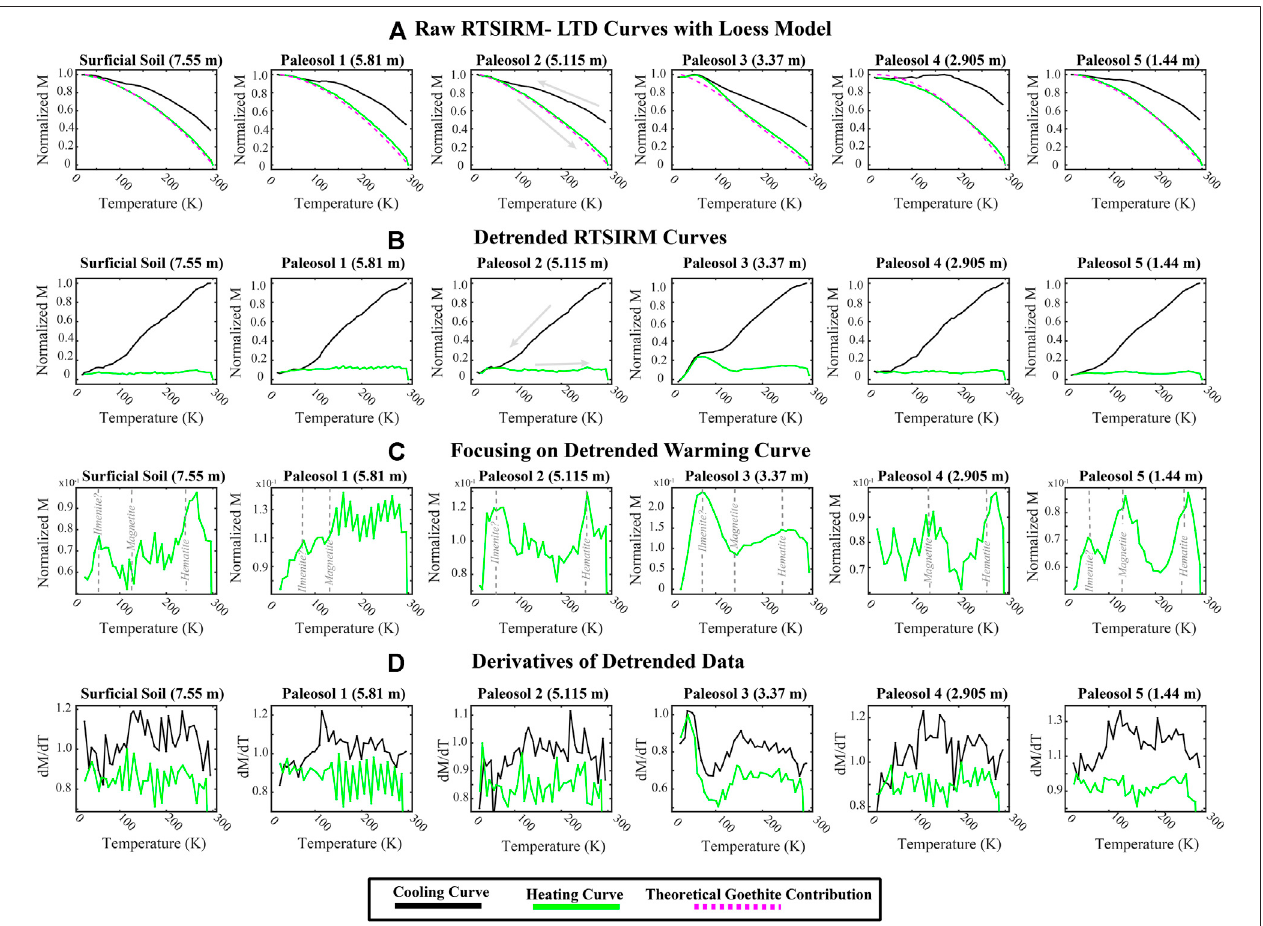
FIGURE 7 | RTSIRM-LTD data. 7a: Cooling (black) and warming (green) RTSIRM curves for all fi ve paleosols and the Sur fi cial Soil. Note the humps present on the coolingcurve,thisisindicativeofmaghemitization(ÖzdemirandDunlop,2010).Thedashedpurplelineisaloesssmoothofthewarmingcurve,representingthepotential contribution of goethite which often has a similar parabolic shape in RT-SIRM curves of synthetic samples (Lascu and Feinberg, 2011). 7b: Subtracting the loess-model from the raw RT-SIRM data, this theoretically removes the goethite contribution. 7c: Focusing on the detrended warming curve, note how the Morin (T M ) and Verwey (T V ) transitions are now visible (Verwey, 1939; Morin, 1950). 7d: Derivatives of the Smoothed RTSIRM curves with respect to temperature. Note the change in slope of the dM/dT cooling curves at ∼ 120 K evident in all the soils, this is interpreted to be the Verwey transition that the detrending procedure enhances.